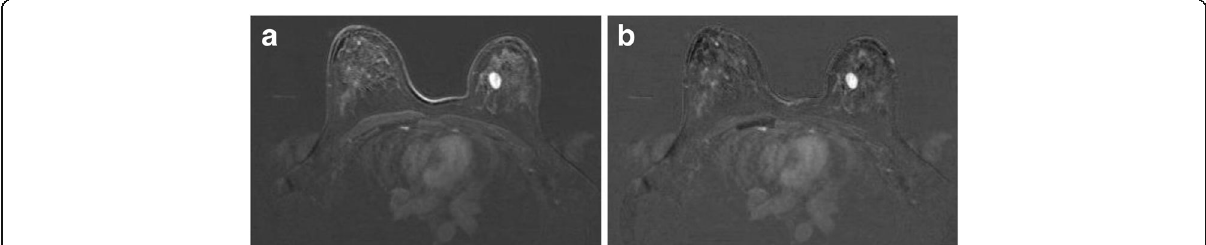
Fig. 2 The influence of motion correction. Subtracted images for a patient with an oval benign lesion in the left breast at the fifth post-contrast time point a before and b after applying motion correction